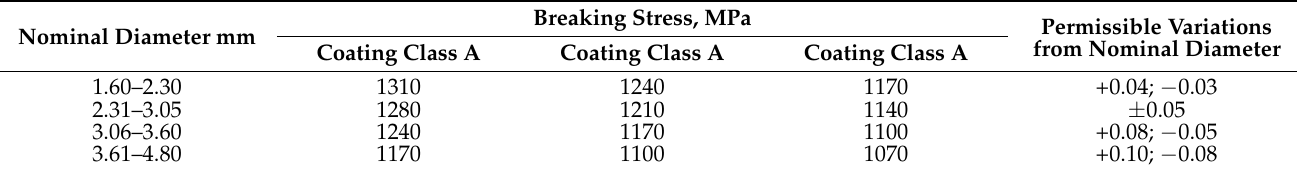
Table 3. Tensile requirement and diameter tolerance of zinc-coated, steel-core